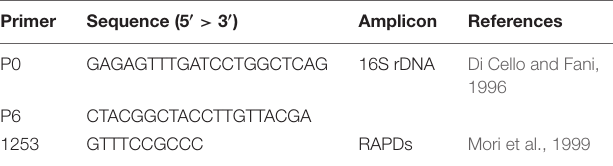
TABLE 1 | Primers used in this work. TABLE 2 | Classes and targets of the antibiotics used in this